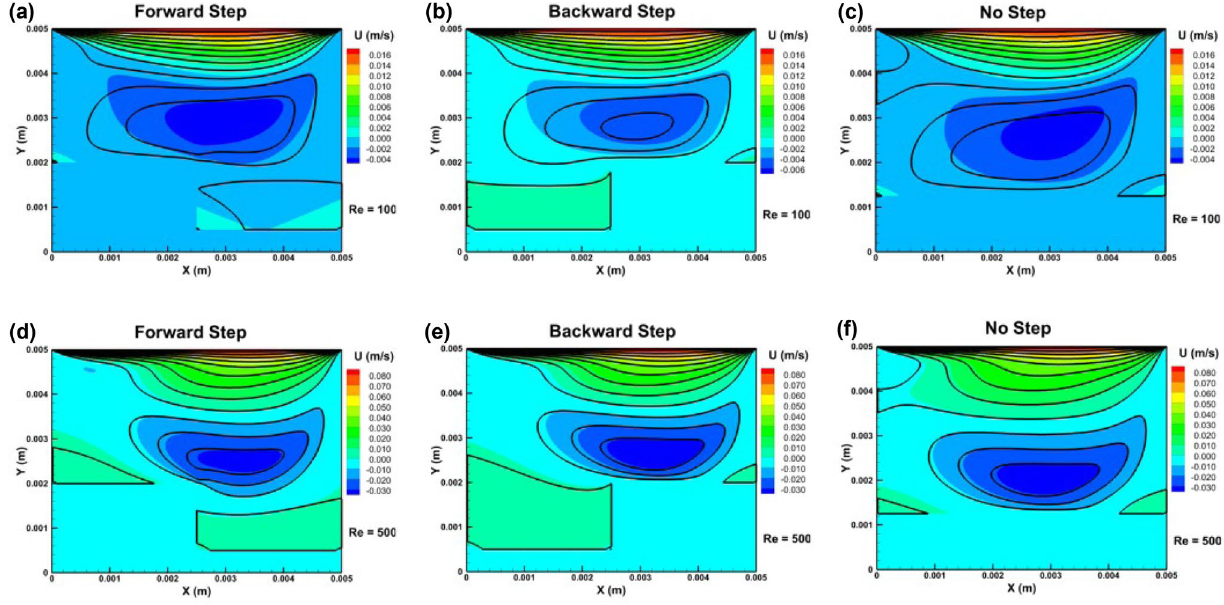
Fig. 4 Overlapped X-directional velocity contours of forced and mixed convection in all three geometrical configurations for pure water (colored contour for forced and solid black line for mixed) at Gr = 20,000: a to c at Re = 100, d to f at Re =